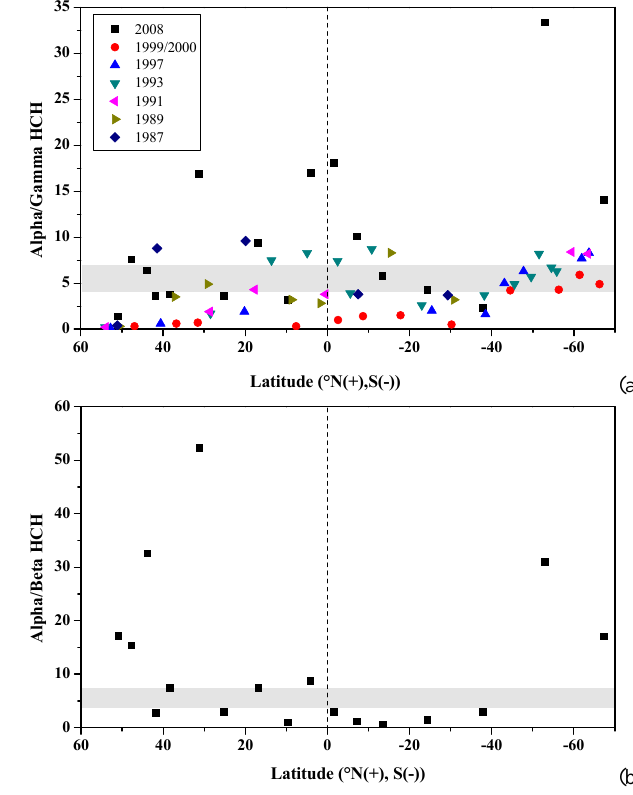
Fig. 3. Temporal and latitudinal distribution of α -HCH (a) and γ - Figure 3. HCH (b) in the Atlantic and the Southern Ocean measured during cruise ANT-V (1987), ANT-VII (1989), ANT-X (1991), ANT-XI (1993), ANT-XV (1997), ANT-XVII (1999/2000) and ANT-XXV (2008, this work).